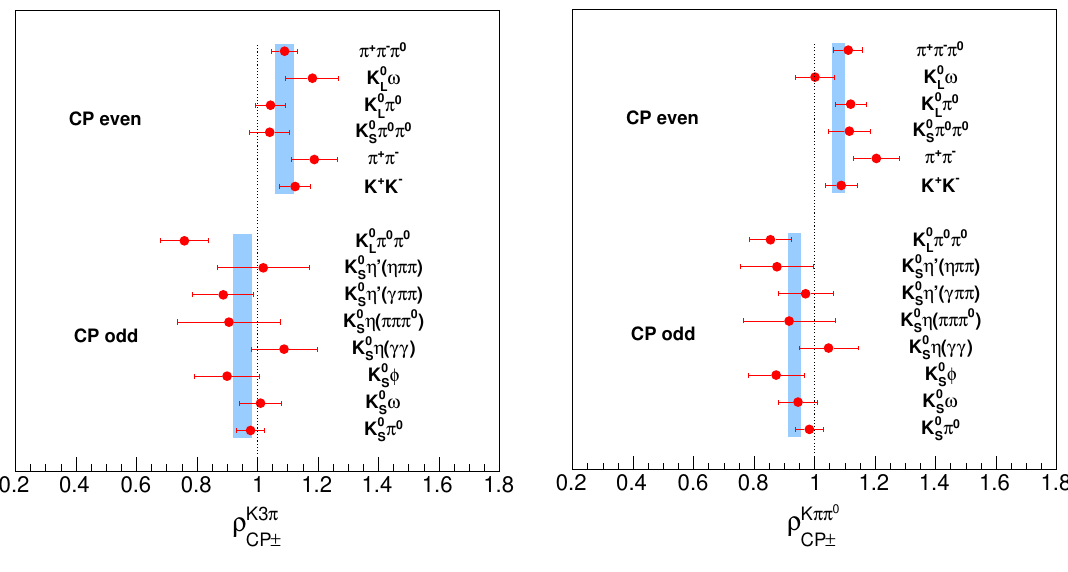
and ρ S observables for (left) S = K − π + π + π − and (right) S = K − π + π 0 . Figure 6 . The ρ S CP + CP − The error bars indicate the sum in quadrature of the statistical and systematic uncertainties. The blue bands represent the ± 1 σ bound for the averaged results of each